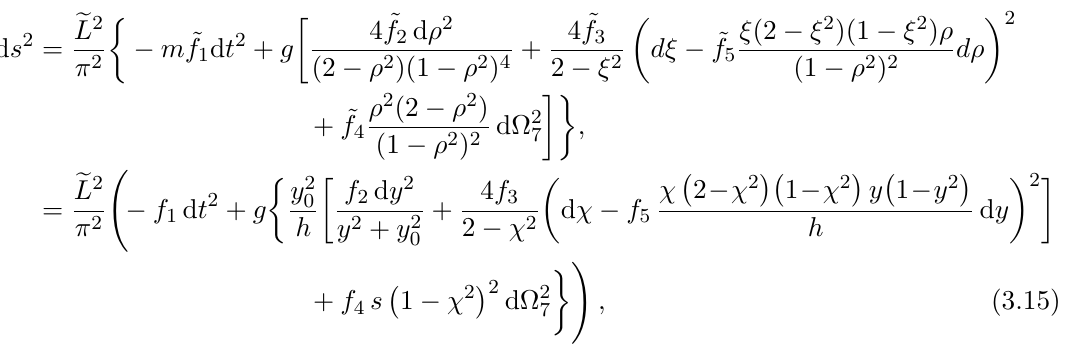
Figure 2 . Sketch of integration domain in f r; e (cid:18) g coordinates. The f (cid:26); (cid:24) g coordinates we use are directly related to these coordinates via r = (cid:26) lines are lines of constant (cid:31) and constant y